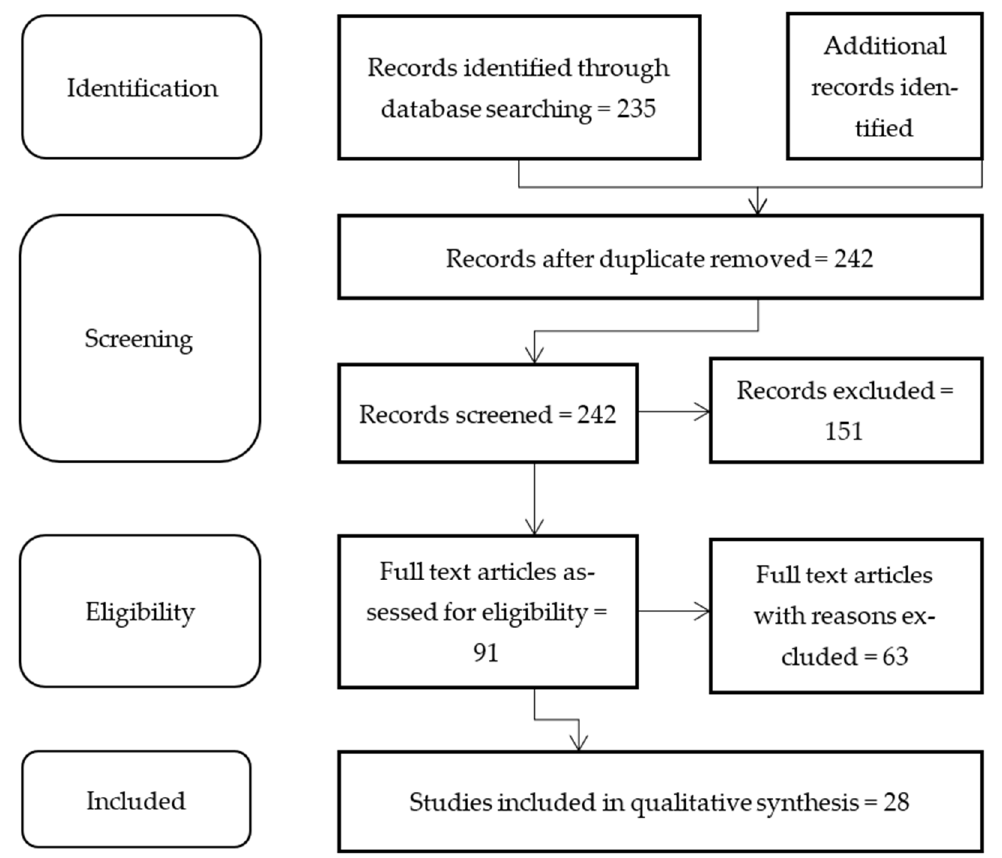
Figure 1. Methodology of search followed during the review process.